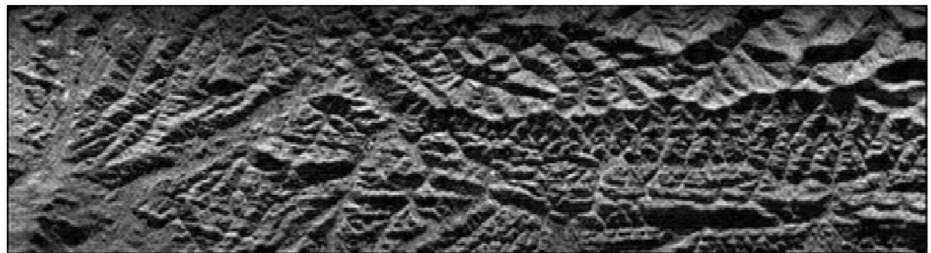
Figure 13. Imaging result of distributed